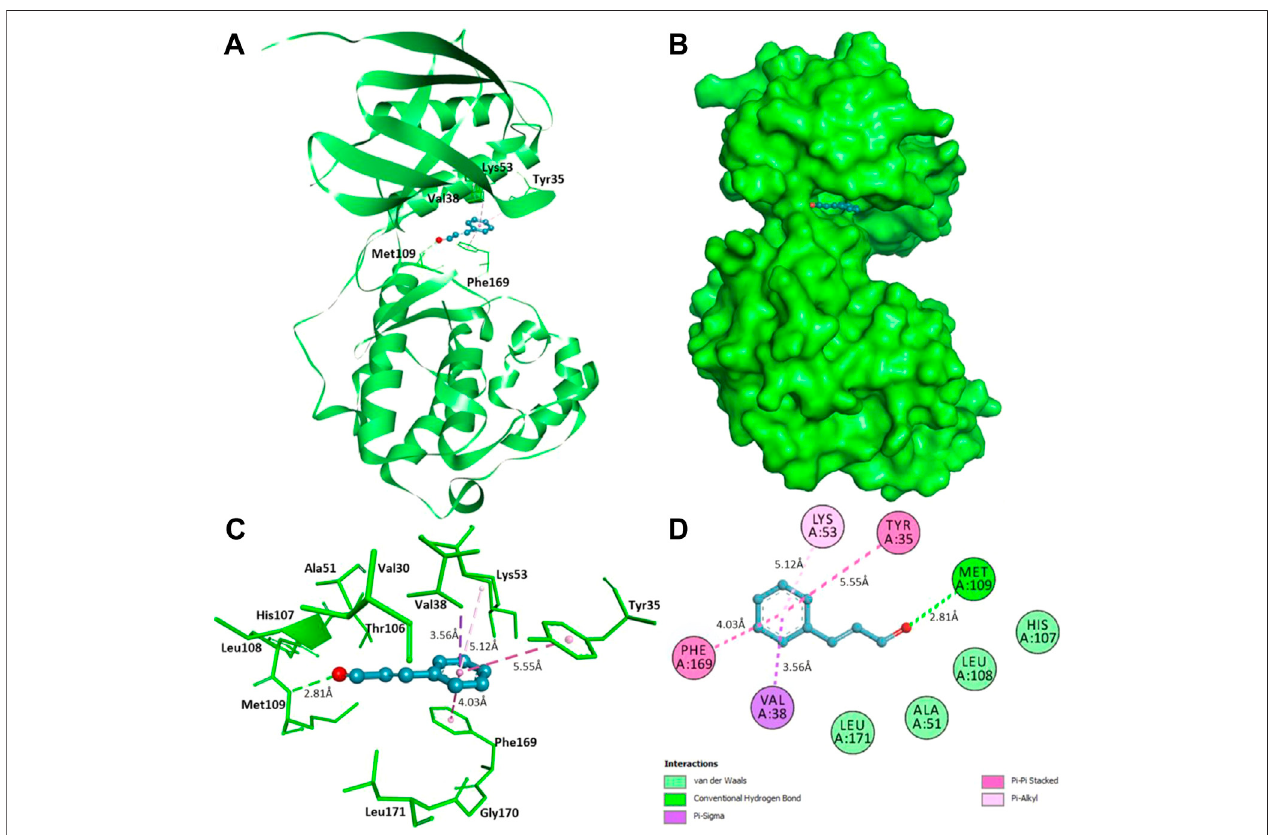
FIGURE 9 | Interaction of CIN to MAPKP-38 α (A) Cartoon representation of MAPKP-38 α in-complexed with CIN (B) Surface view of MAPKP-38 α in-complexed with CIN (C) 3D representation of interacting residues of MAPKP-38 α with CIN (D) 2D plot of interacting residues of MAPKP-38 α with CIN.